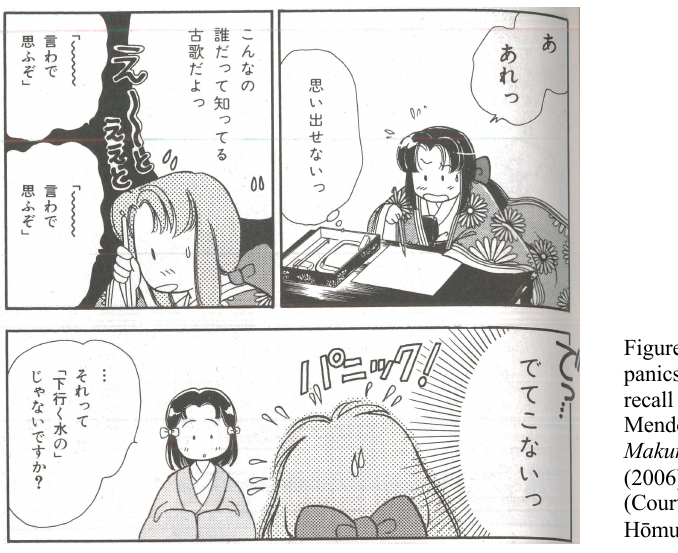
Figure 3. Sei panics trying to recall a poem. Mendō Kazuki, Makura no sōshi (2006), 245. (Courtesy of